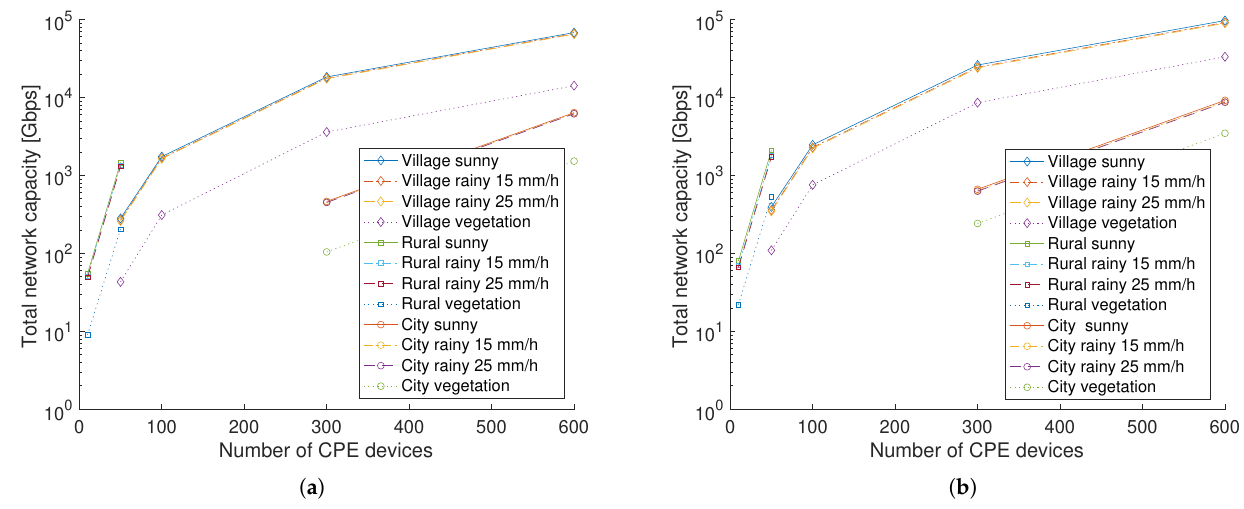
Figure 4. Averaged total network capacity as a function of the number of customer premises equip- ment ( CPE ) devices. ( a ) 60 GHz. ( b ) 140